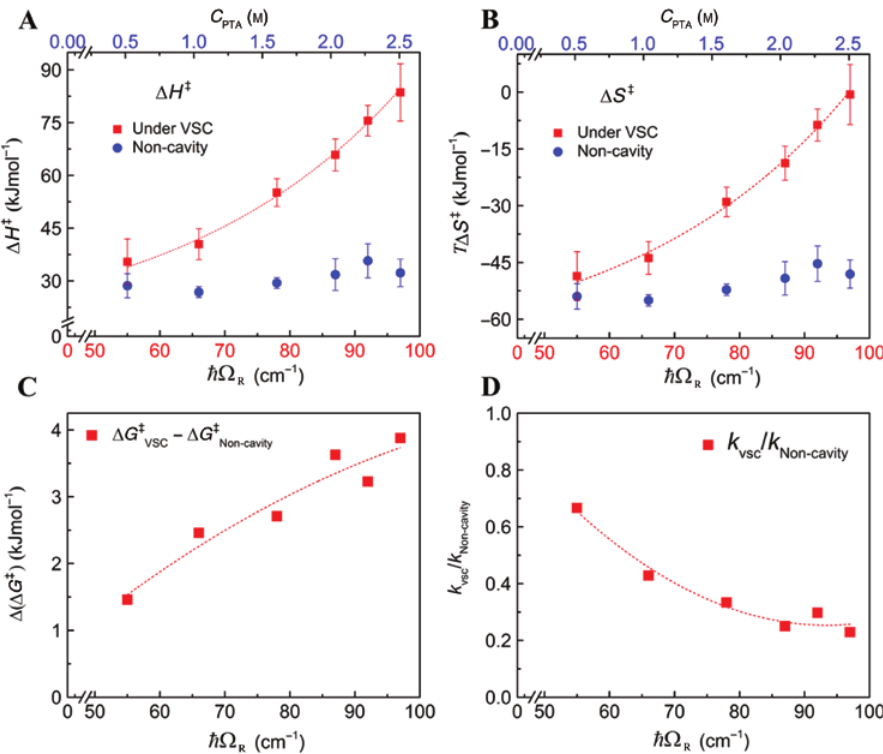
Figure 3: Variation of thermodynamic parameters of as a function of Rabi splitting energy. Plots showing the changes in (A) the enthalpy of activation and (B) entropy of activation ( T Δ S ‡ , T = 298 K) under VSC (red squares). The blue circles represent the corresponding noncavity values for the various C shown in top axis. (C) Shows the difference between the free energy PTA of activation under VSC with increasing ħ Ω at normal incidence and the noncavity situation at the same C . (D) The decrease in the ratio of R PTA the reaction rates at 25 ° C under VSC for various values of ħ Ω relative to the noncavity situation. The dashed lines are guides to the eye. R